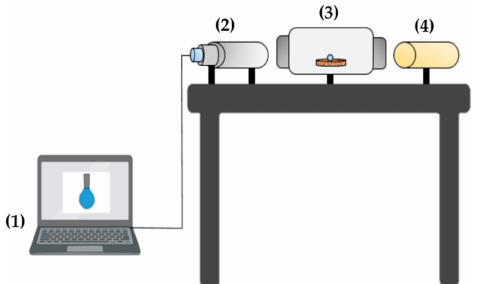
Figure 2. Experimental setup for contact angle measurement in the theta optical tensiometer. The four main components of the assembly are observed: (1). Software, (2). High-definition camera, (3). High-pressure cell, and (4). Light